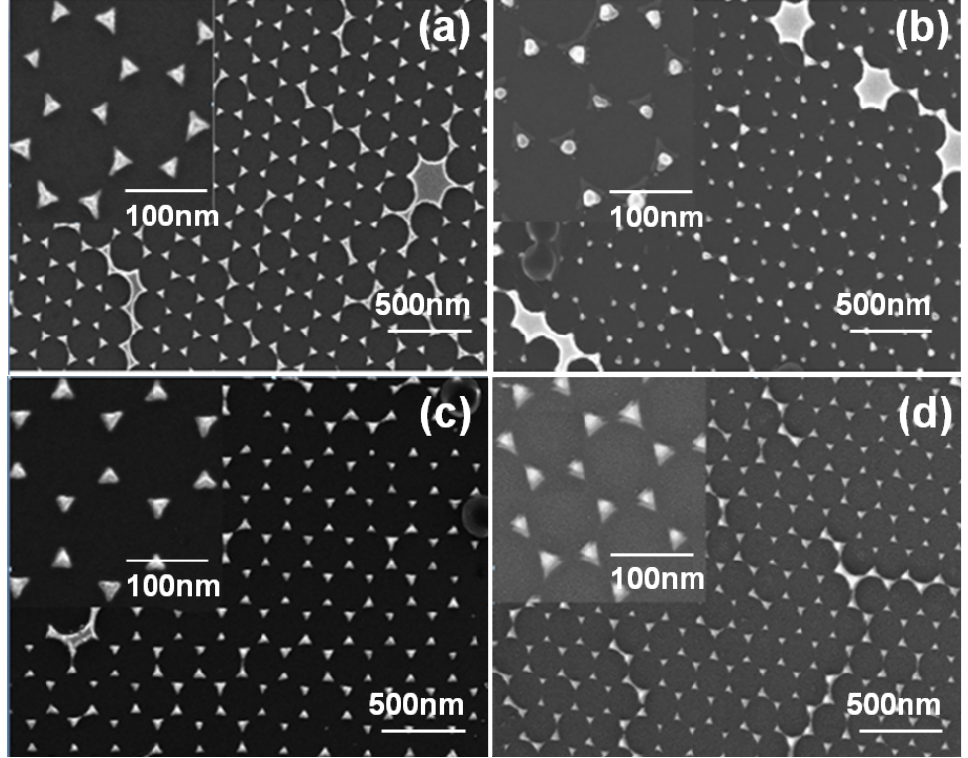
Figure 5. SEM (scanning electron microscope) images of the hybrid Au-Ag